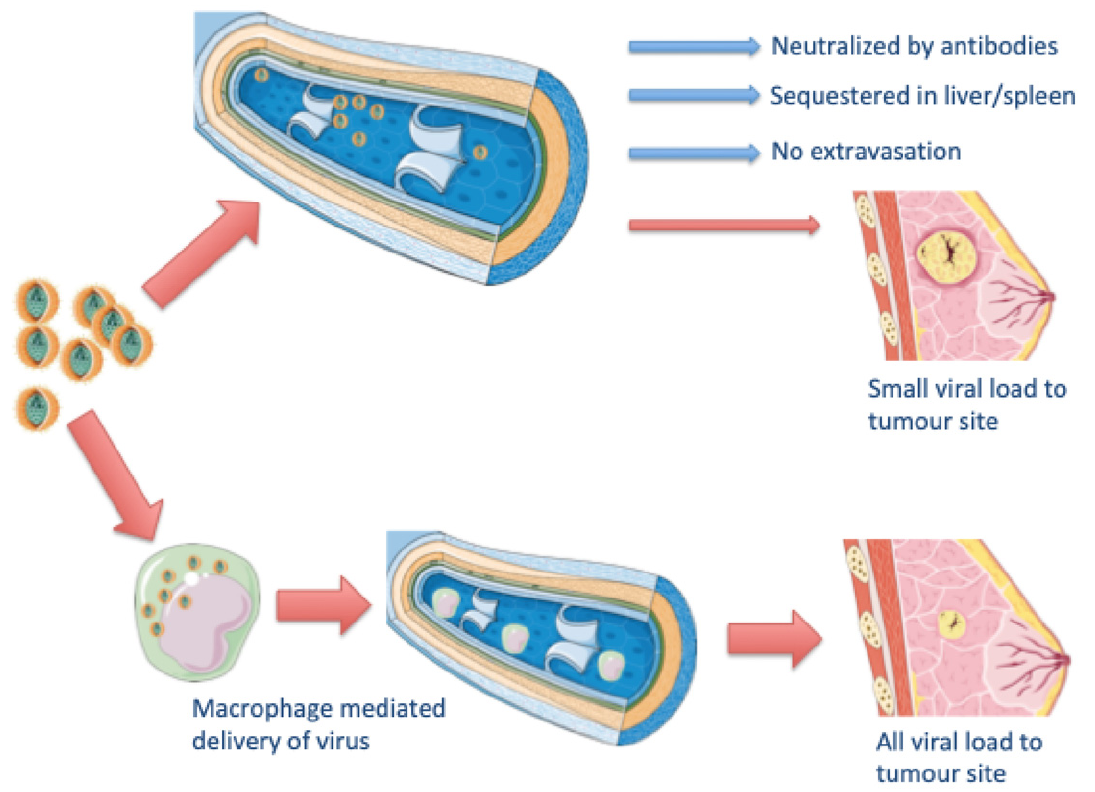
Figure 5. Potential for M-HSV1716 in TNBC. A schematic representation of how macrophages with virus may be used to target breast cancer.